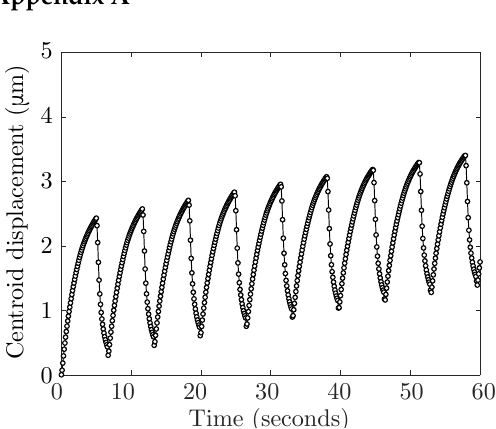
Figure A1. The centroid displacement in the horizontal direction over 60 s of a cell with a bleb neck size of 16 µ m confined in a straight rigid channel with gap width of 13 µ